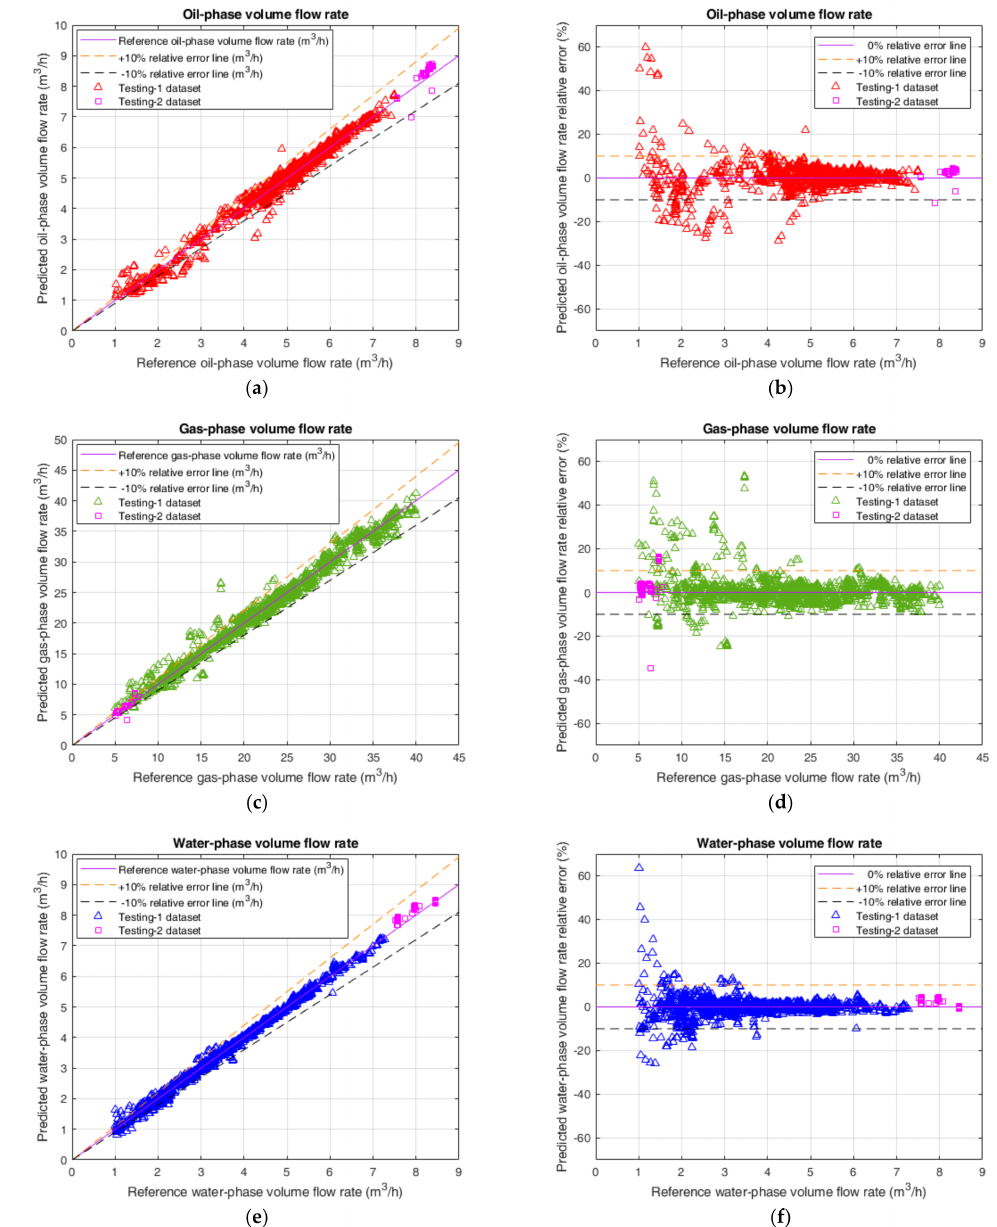
Figure 7. The predicted results on the testing-1 and testing-2 datasets of the proposed CNN-based volume flow rate prediction model combined with ensemble learning. ( a ) The volume flow rate prediction of the oil-phase; ( b ) The prediction relative error of the oil-phase; ( c ) The volume flow rate prediction of the gas-phase; ( d ) The prediction relative error of the gas-phase; ( e ) The volume flow rate prediction of the water-phase; ( f ) The prediction relative error of the